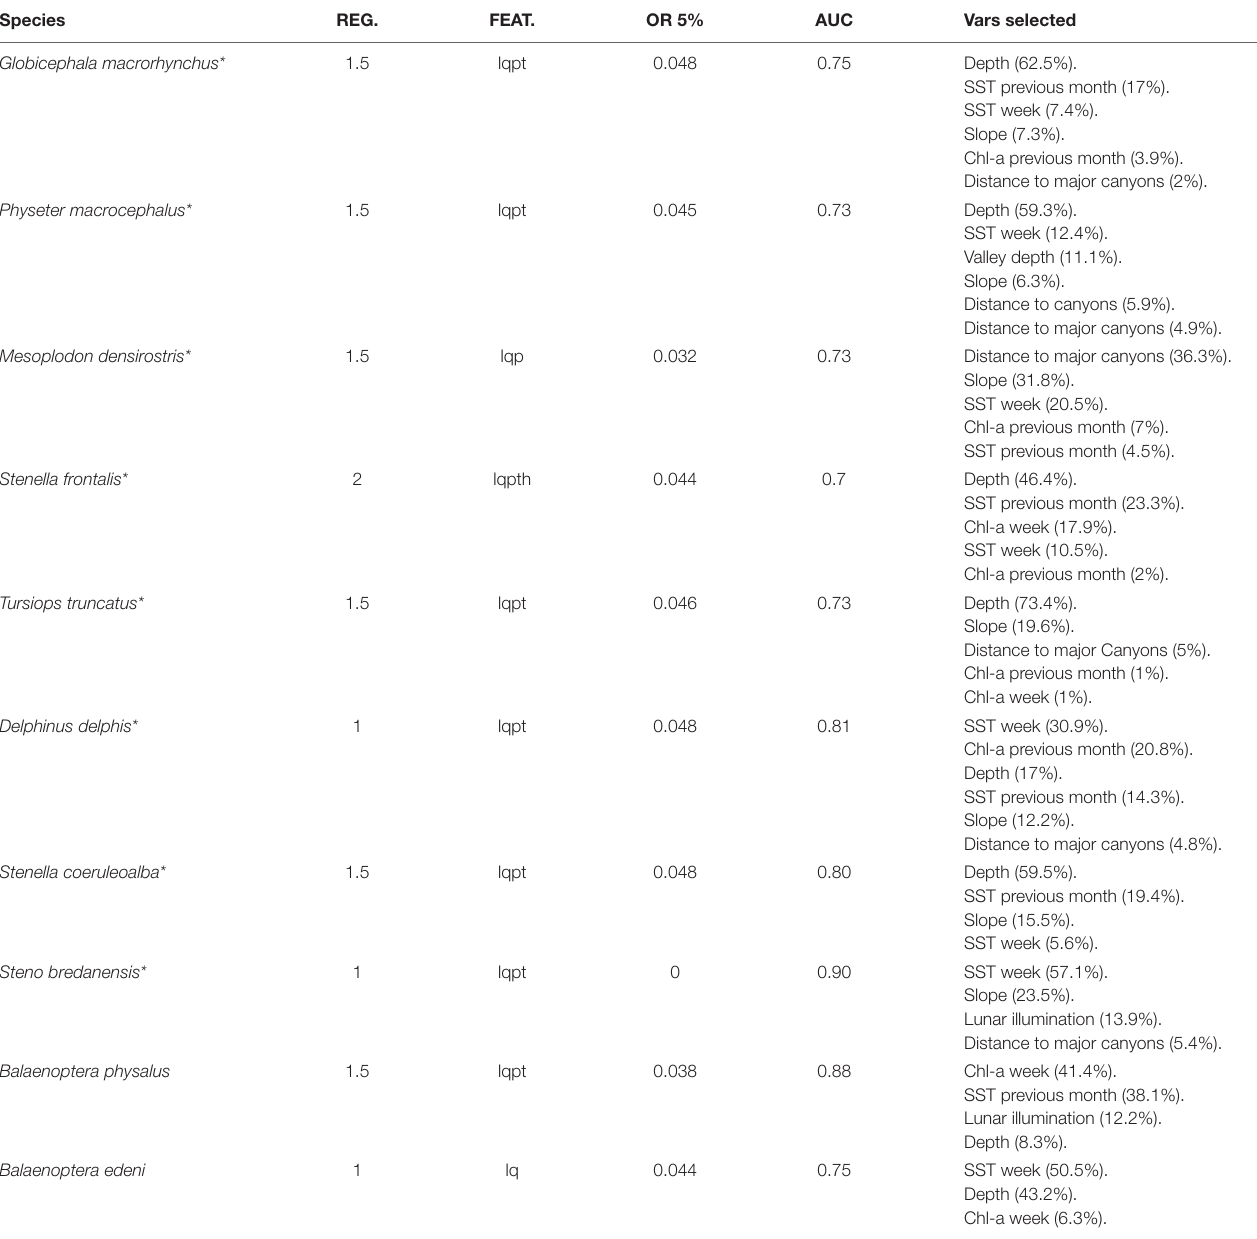
TABLE 3 | Eight-days models regularization multiplier (REG.), feature classes (linear = l, quadratic = q, product = p, threshold = t, and hinge = h), omission rate at 5% (OR 5%), area under the curve (AUC), and variables selected (with its contribution) for each species. Species REG.